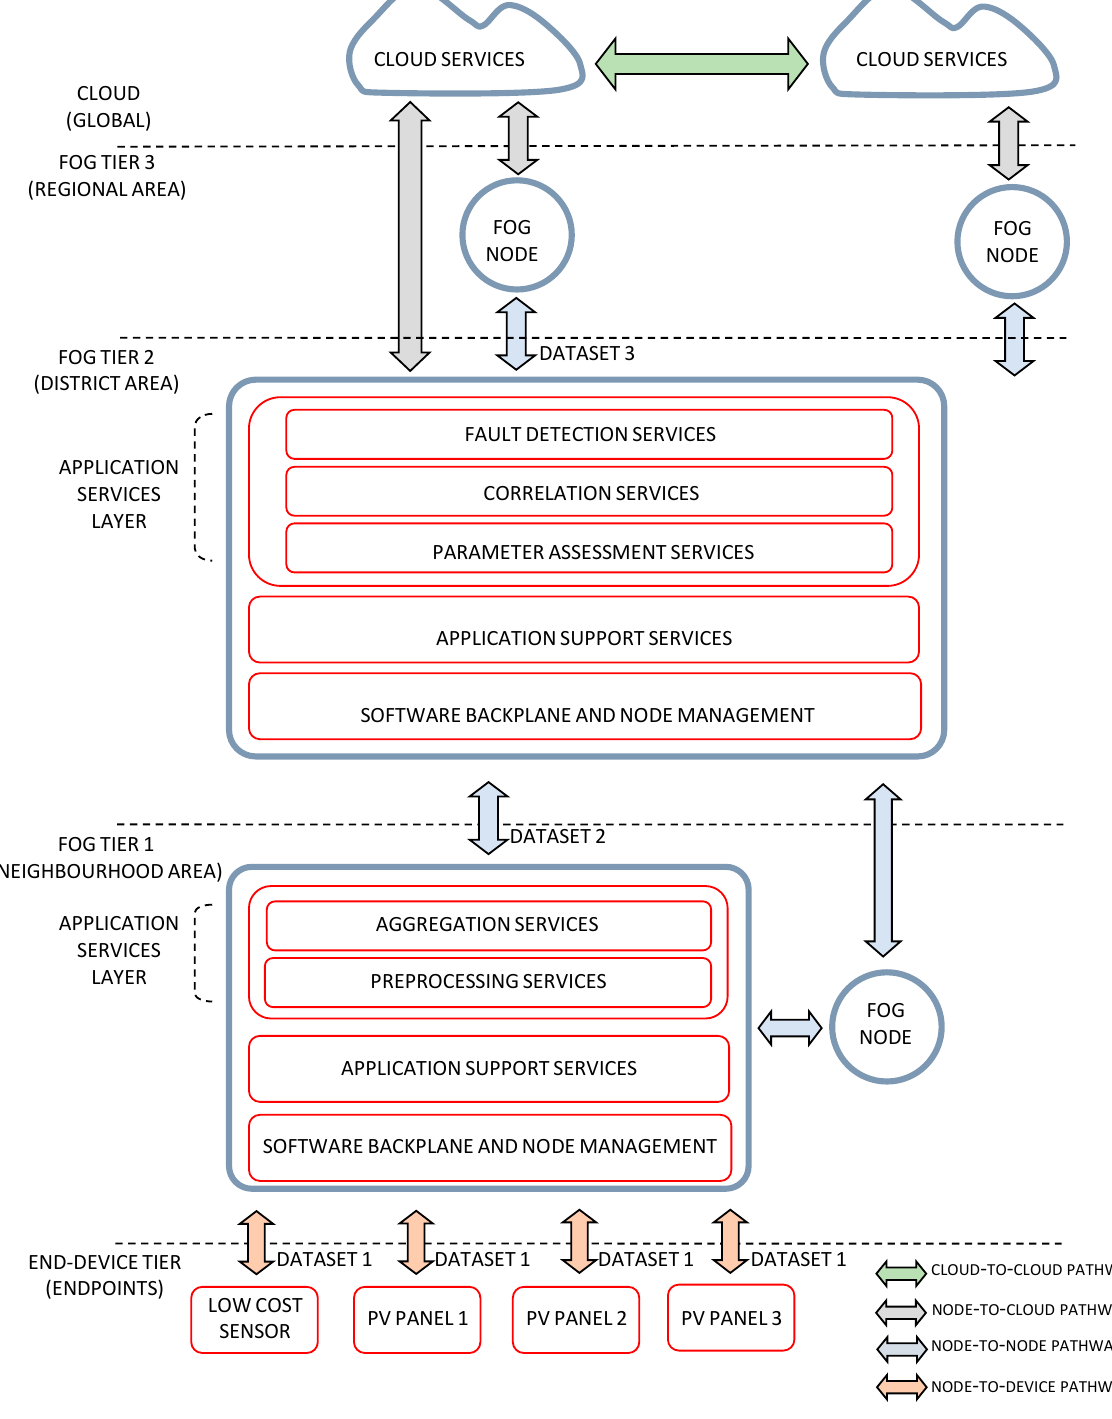
Figure 1. Tiered fog-based system architecture.